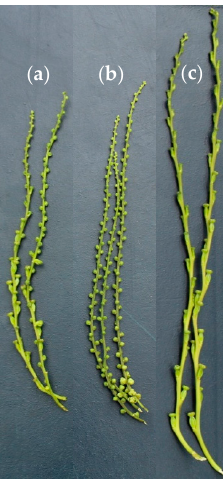
Figure 2. Dioscorea rotundata inflorescences showing ( a ) staminate and pistillate flowers, ( b ) staminate flowers, ( c ) pistillate flowers.